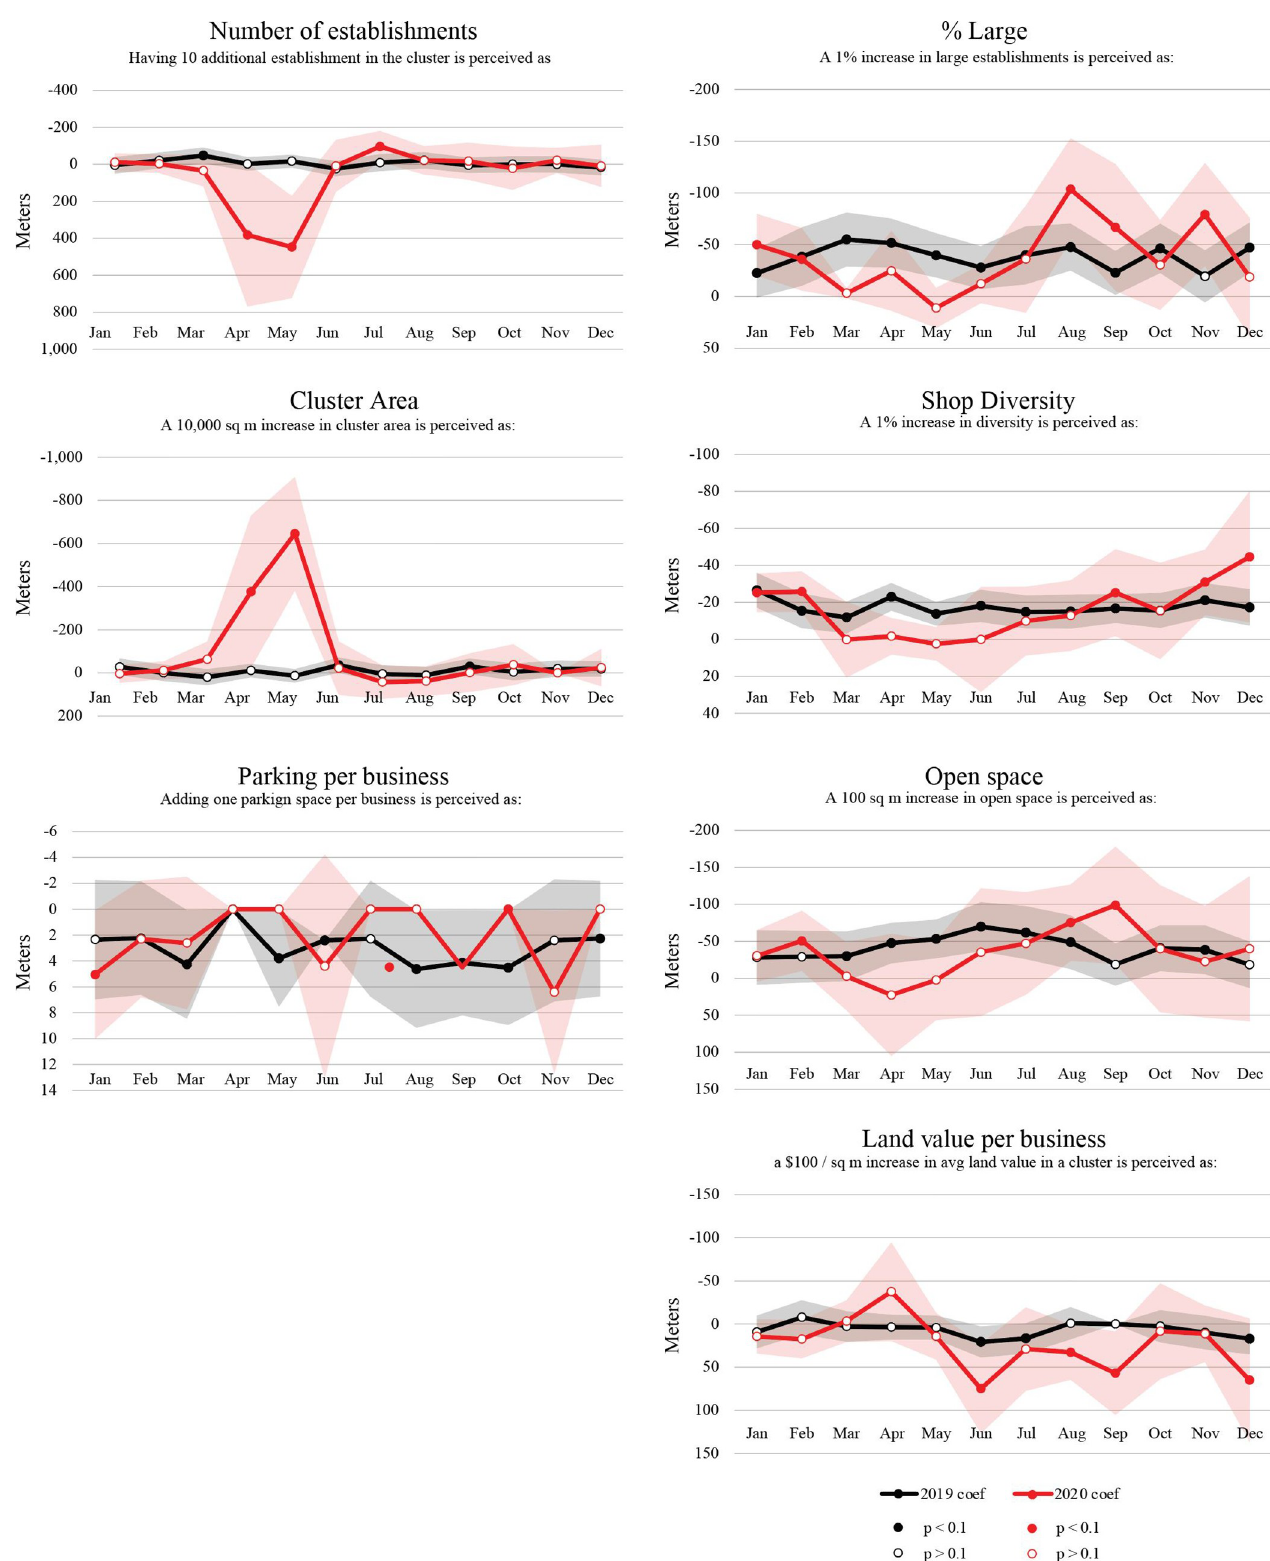
Fig 6. Estimated preferences towards physical characteristics of destination clusters. Trend lines represent distance-equivalent coefficients (ratio between coefficient and distance coefficient). https://doi.org/10.1371/journal.pone.0252794.g006 PLOS ONE | https://doi.org/10.1371/journal.pone.0252794 September 1,